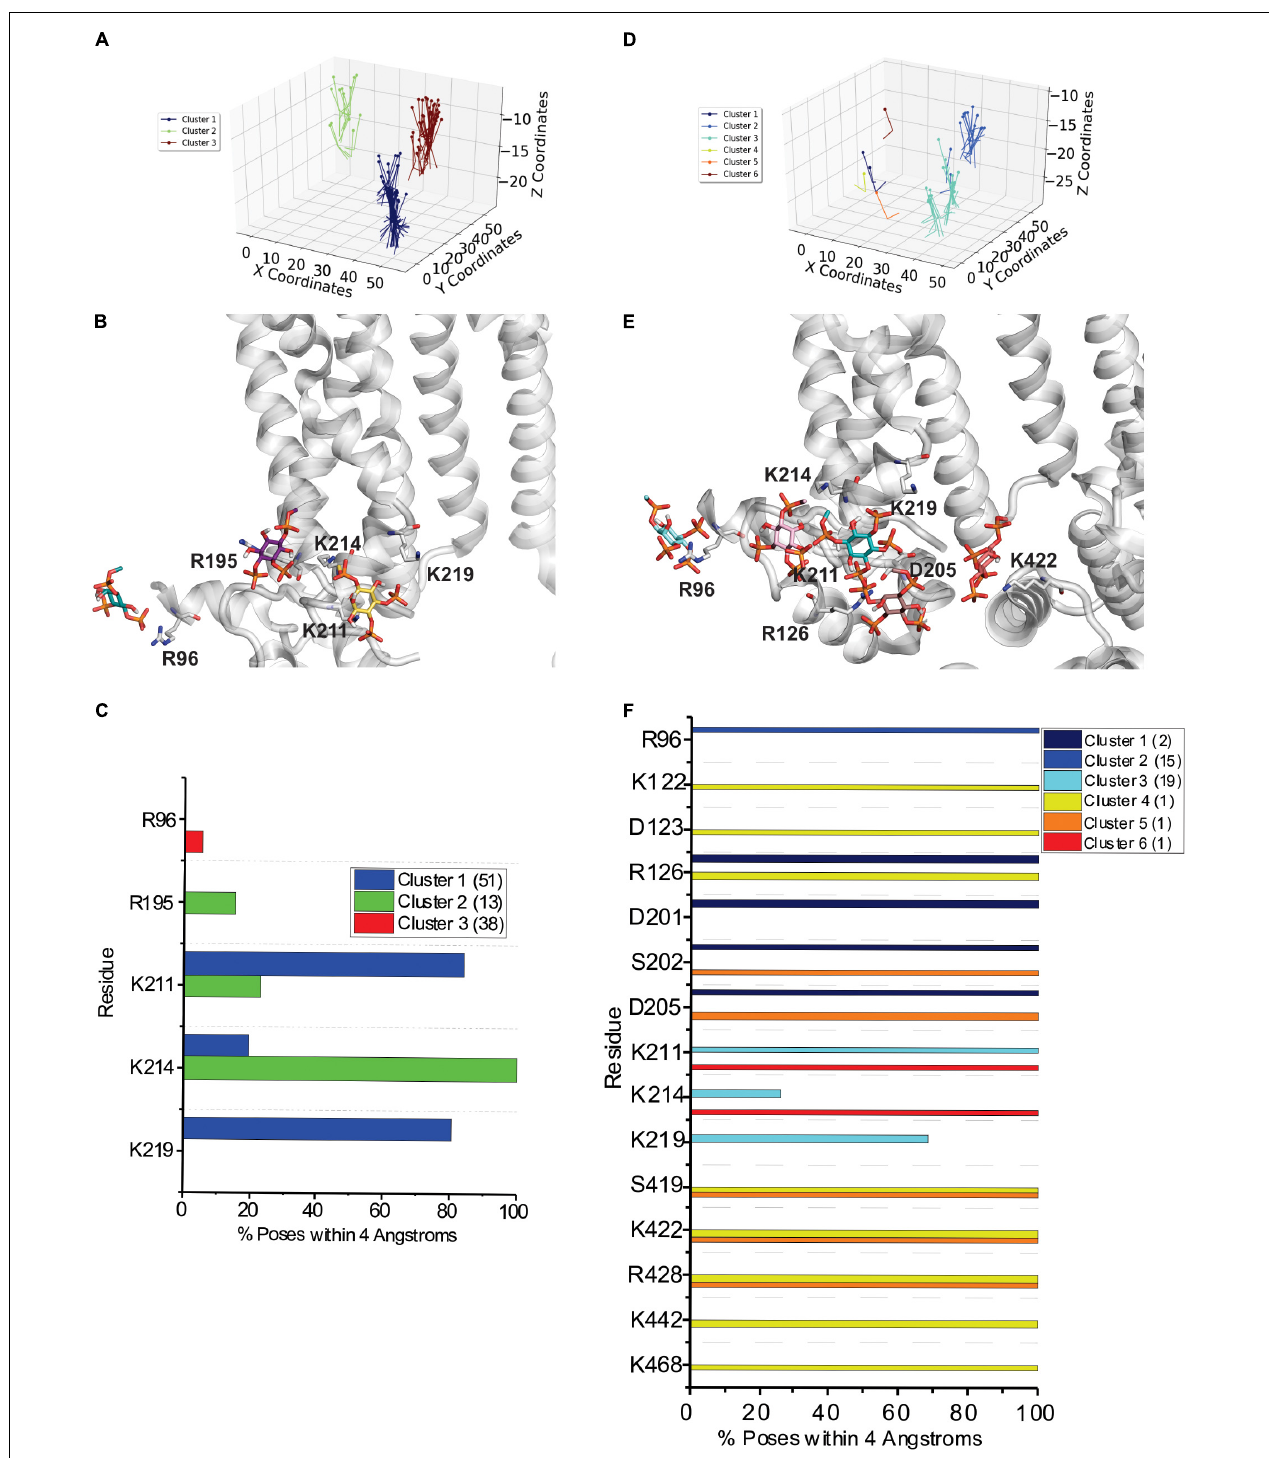
FIGURE 2 | Docking of PI(4,5)P 2 and PI(3,4,5)P 3 to HCN1 channels with VSDs in the up (closed) conformation. (A) The results from 500 attempts to dock PI(4,5)P 2 headgroups to HCN1 (PDB: 5U6O). Poses were accepted based on orientation and clusters were identified in an automated manner using MultiCluster software previously described (Tanguay et al., 2019). (B) Binding sites of the most representative poses for each cluster (C) The frequency of residues within 4 Å of the PI(4,5)P 2 ligand for each pose was assessed and is indicated as a percentage of the accepted poses. (D) The results from 500 attempts to dock PI(3,4,5)P 3 headgroups to HCN1. (E) Binding sites of the most representative poses for each cluster (F) The frequency of residues within 4 Å of the PI(3,4,5)P 3 ligand for each pose was assessed and is indicated as a percentage of the accepted